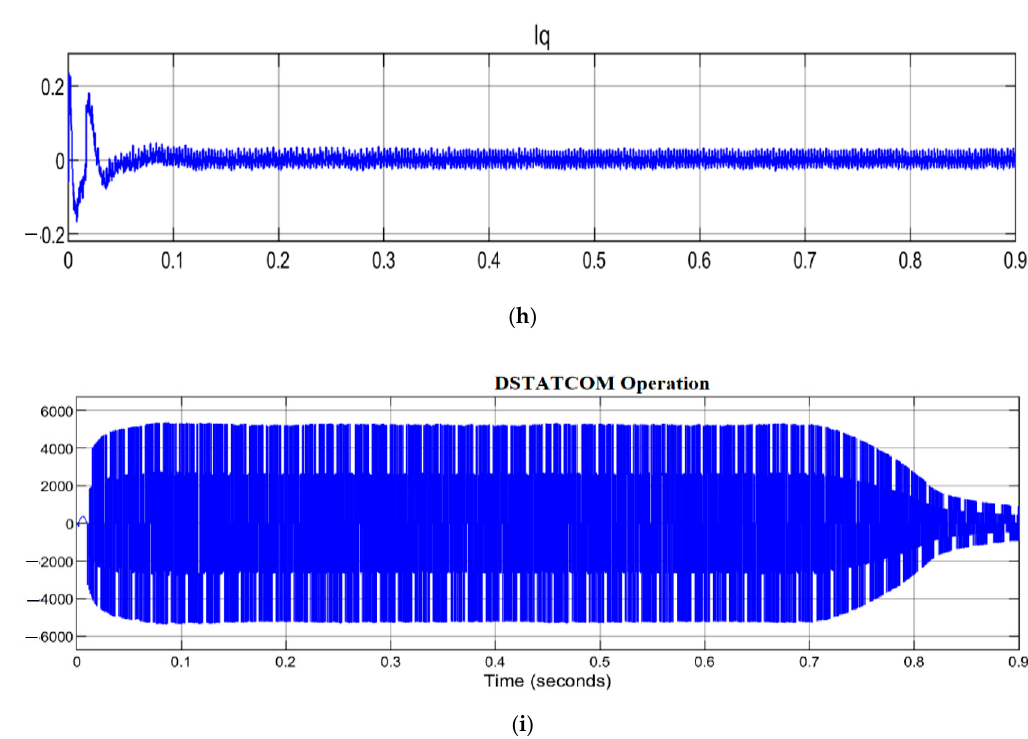
Figure 16. ( a ) PCC Line Voltage and Current, ( b ) Solar Irradiance, ( c ) Peak Power Point Tracking, the blue is the tracking sequence while the green line is the error regulator ( d ) PCC Phase Voltage, ( e ) PV Power Output, ( f ) DC Voltage, ( g ) Solar Voltage, ( h ) Grid Reactive Power and ( i ) DSTATCOM Voltage.